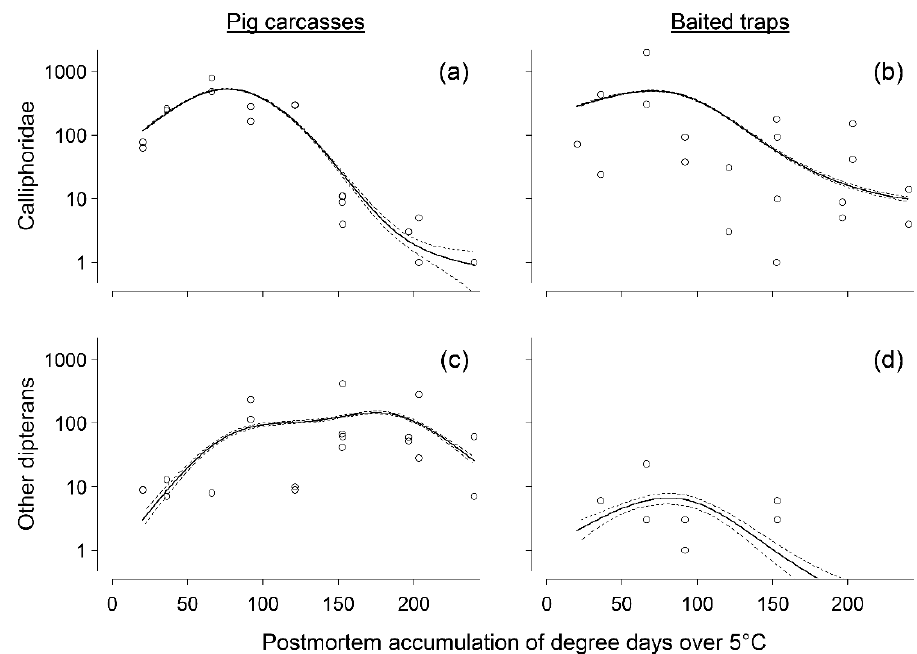
Figure 1. Dipterans documented as a function of postmortem accumulated degree-days over 5 °C, for: ( a ) Calliphoridae observed on carcasses ( r 2 = 0.63; edf = 3.903; F = 442; p < 0.01), ( b ) Calliphoridae captured in baited traps ( r 2 = 0.09; edf = 2.997; F = 676.7; p < 0.01), ( c ) other dipterans observed on carcasses ( r 2 = 0.05; edf = 3.961; F = 87.03; p < 0.01) and ( d ) other dipterans captured in baited traps ( r 2 = 0.10; edf = 2.555; F = 8.87; p < 0.01). The solid black line indicates the model prediction and the confidence interval of the prediction is illustrated with small dashes.